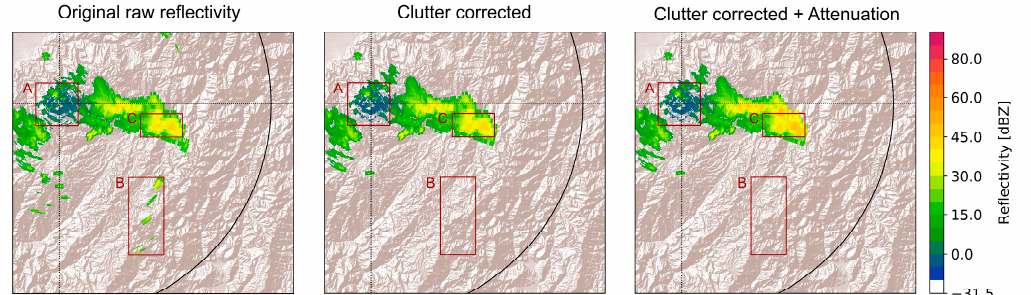
Figure 5. Static-Dynamic clutter and attenuation correction applied to the radar scene from 2017.02.10 15:45 local time. From left to right: (i) original uncorrected reflectivity, (ii) upscaled reflectivity after static (region A) and dynamic clutter (region B) removal, and (iii) upscaled reflectivity after clutter removal plus attenuation correction (region C).